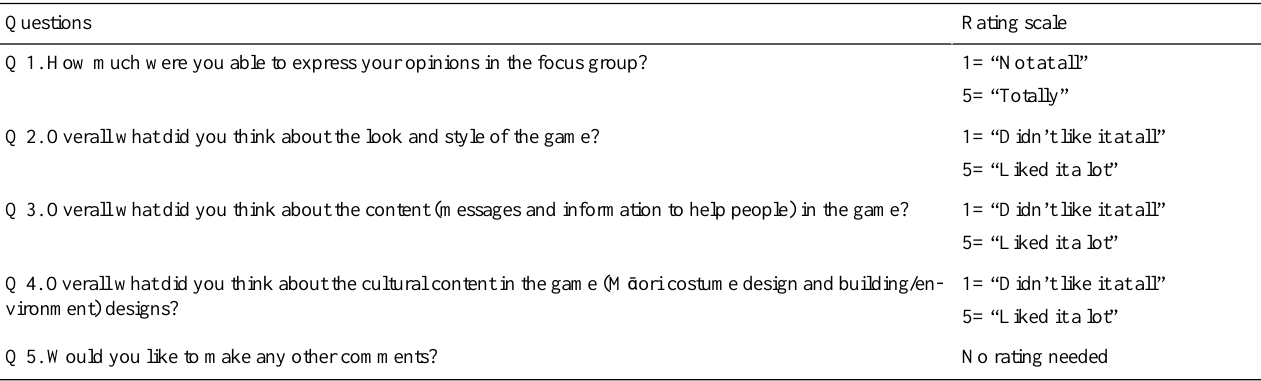
Table 2. Focus group